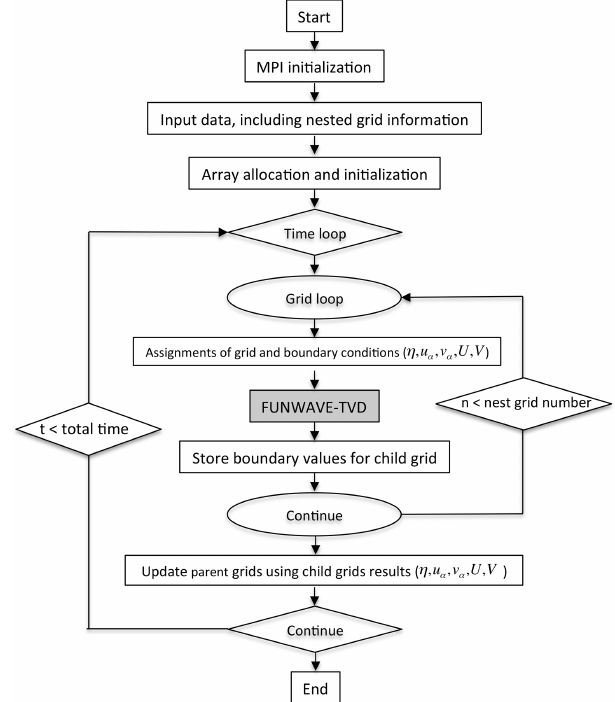
Figure 4. Flowchart of the two-way nesting interface. t and n rep- resent time and grid level, respectively.